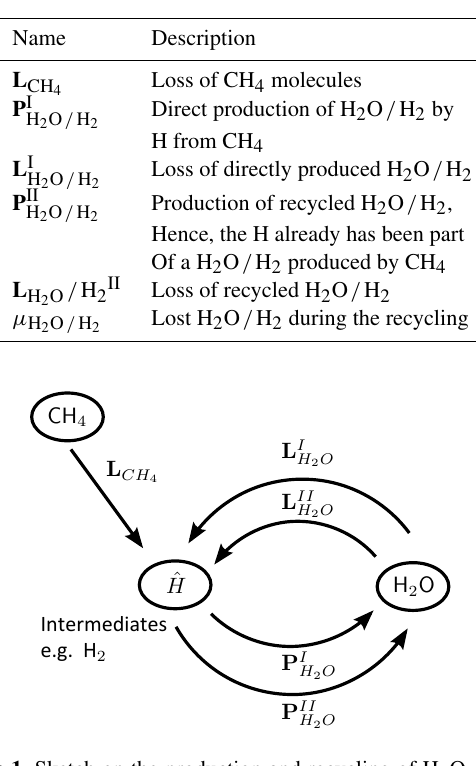
Figure 1. Sketch on the production and recycling of H 2 O. The ar- rows of L CH and P I indicate the direct yield, and all arrows H 2 O 4 together indicate the effective yield.